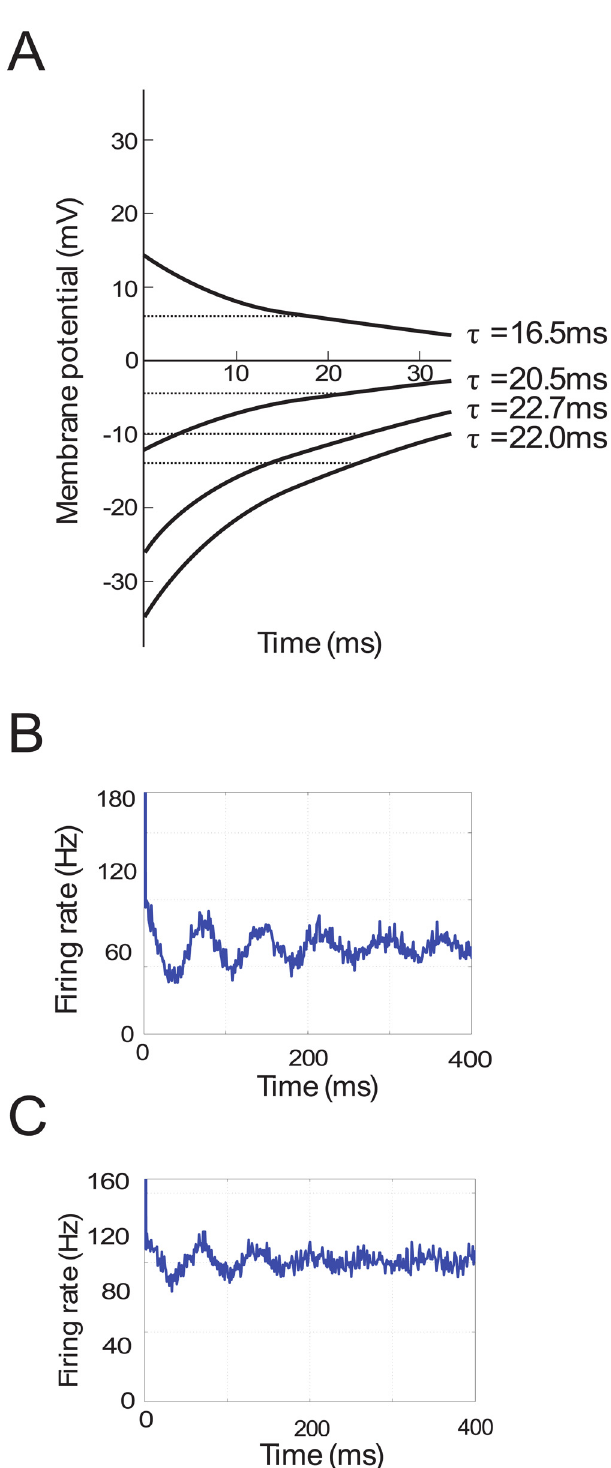
Fig 7. Experimental data used to estimate parameters of the models. A) Changes in the membrane potential of a GPe neuron following current injections. Data taken from Kita and Kitai [61] (Fig 2, Panel A). Dashed lines indicate V 0 e − 1 . B, C) Simulated auto-correlograms of STN and GPe